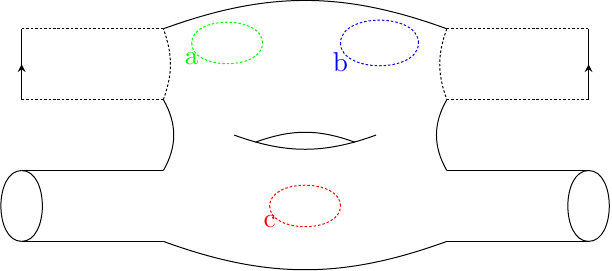
Figure 5 . An example of a 2-morphism illustrating the difference between constrained boundaries attached to in or out-going intervals and the closed constrained boundaries. The latter are the red, green, and blue